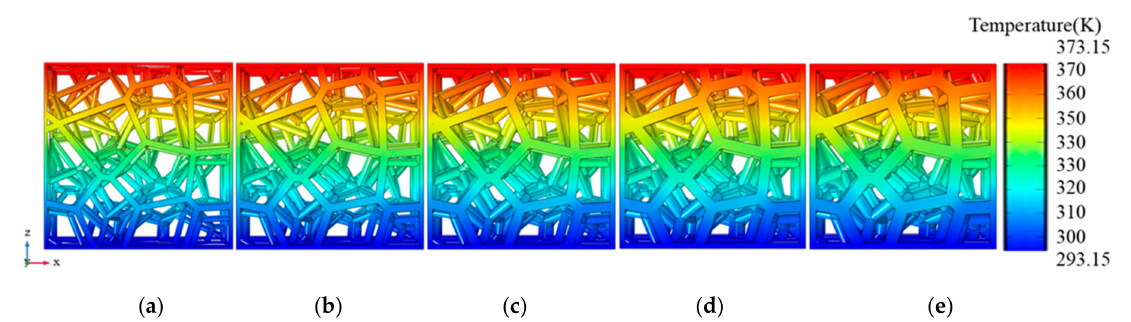
Figure 10. The temperature distribution of the RV50 structure with different porosity in air-saturation environment, the porosity values from left to right are ( a ) 94.98%, ( b ) 91.97%, ( c ) 88.89%, ( d ) 86% and ( e )